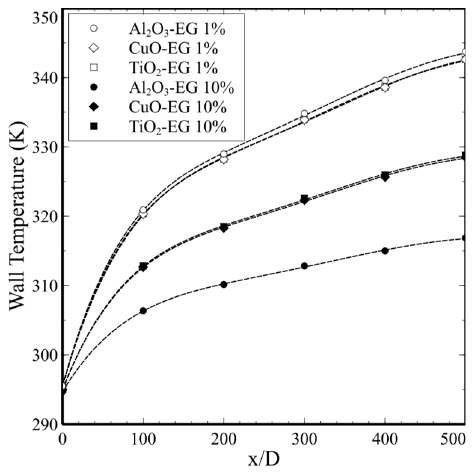
Figure 6. Effect of nanoparticle concentration in tube flow: axial development of wall temperatures.